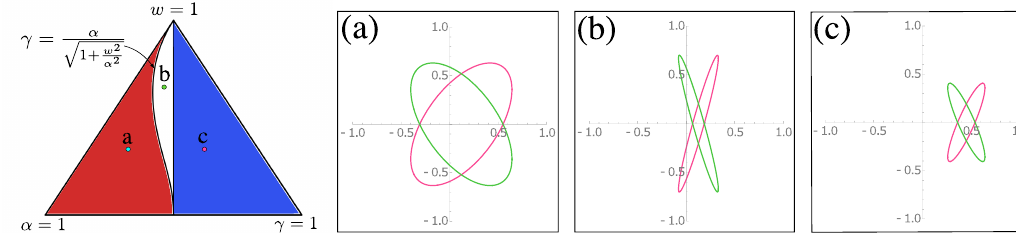
Figure 4: The phase diagram of the effective non Hermitian model. Here blue marks = 0, red marks a gapped topologically a gapped topologically trivial phase with ν 1,2 = 1 and white marks a gapless phase. The insets (a)-(c) show non trivial regime ν 1,2 ( k ) (green curve) and q ( k ) (red curve) around the origin in the the winding of q 1 2 gapless, topological and trivial phases,